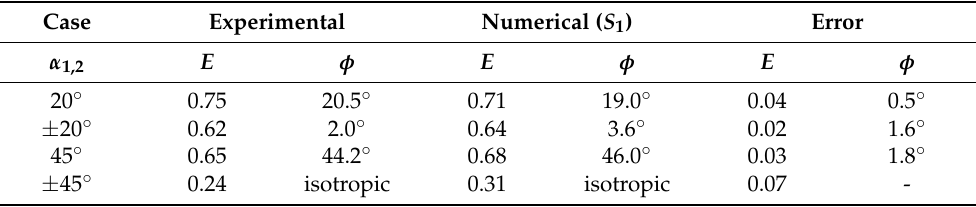
Table 5. Table summarizing the E and the φ parameters resulting from the S 1 simulations at different fiber distributions and thickness